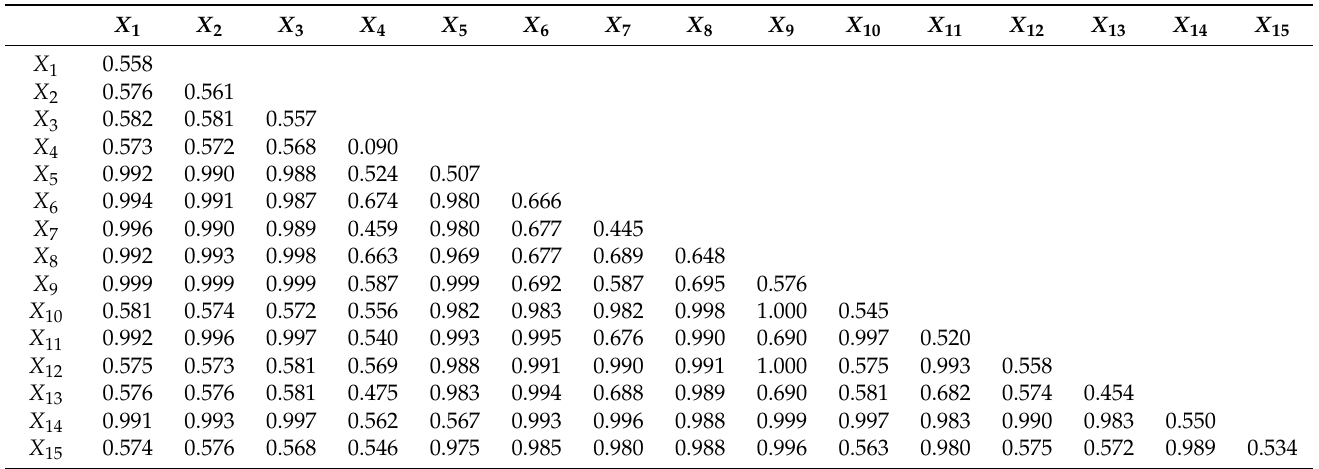
Table 4. Interactive detection analysis results of Geodetector in the YRD (2010).